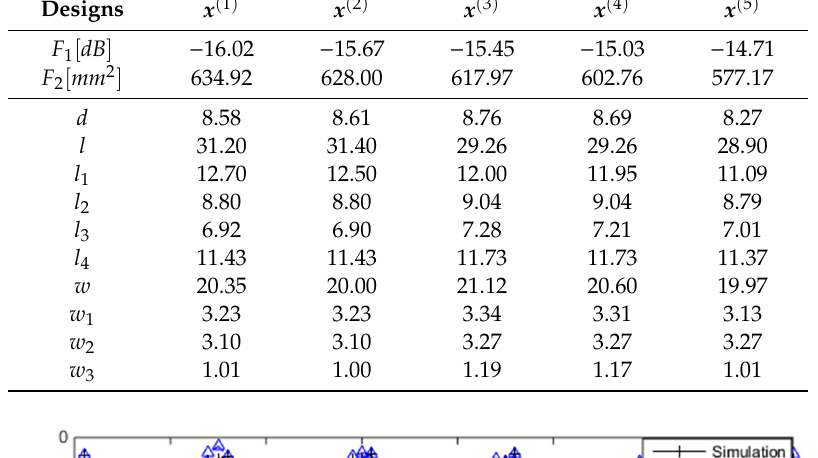
miniaturized multiband antenna.